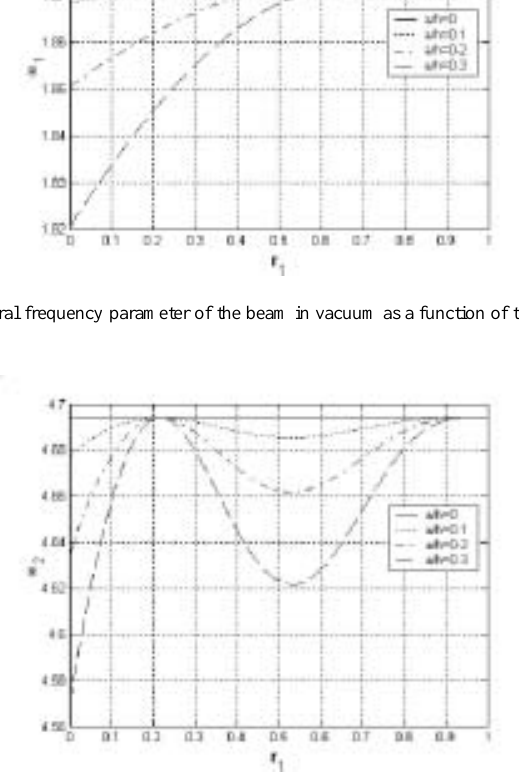
Fig. 9. The second natural frequency parameter of the beam in vacuum as a function of the position of the